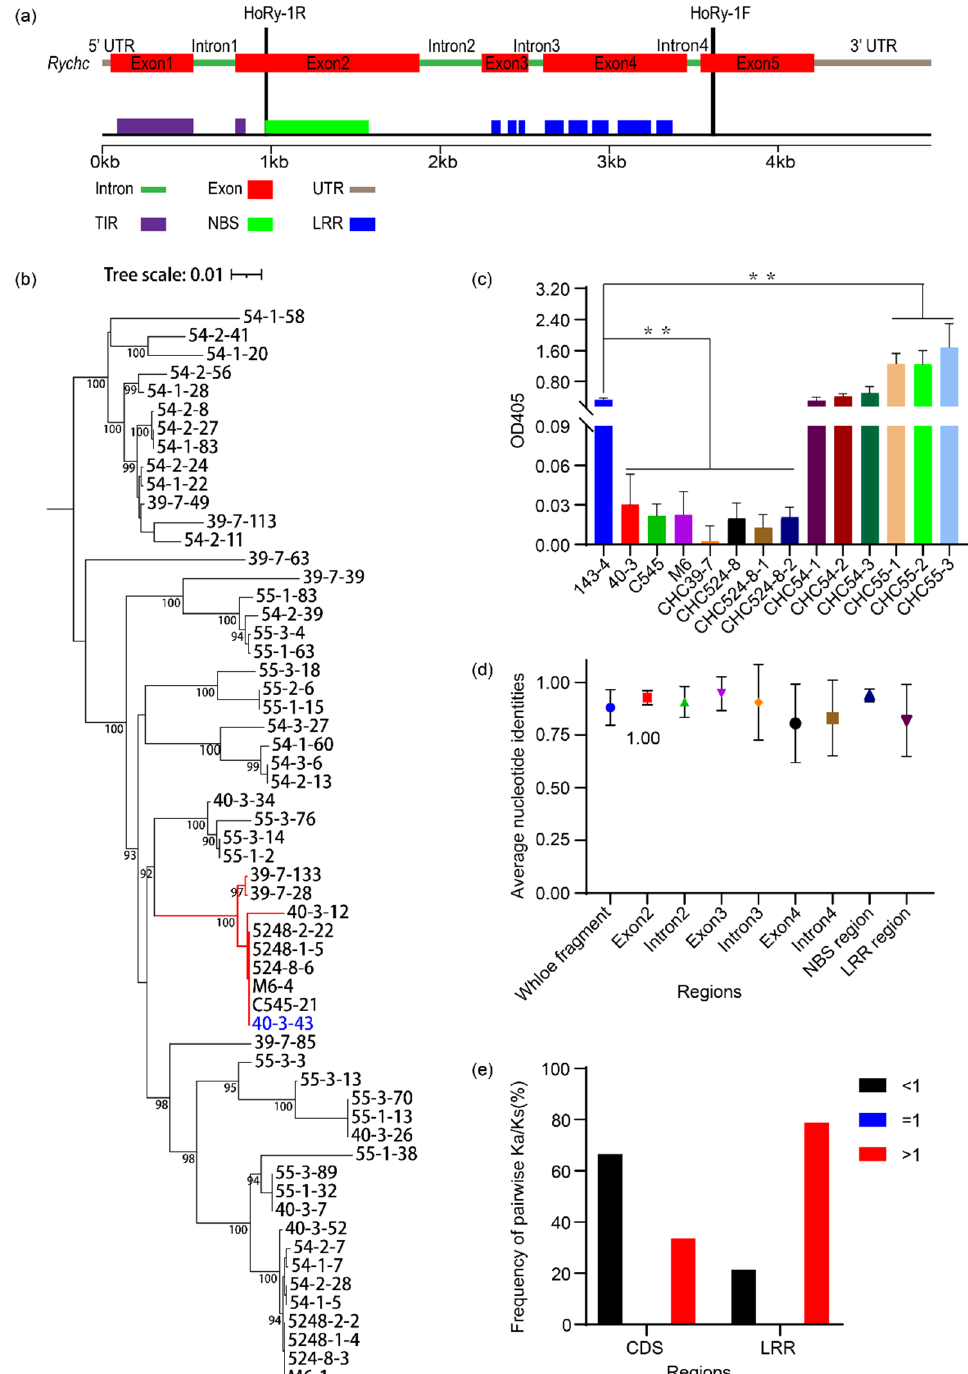
Figure 6. Evolution of Ry chc homologs in diverse wild accessions of S. chacoense . ( a ) Genomic structure and conserved domains of Ry chc ; ( b ) Maximum Likelihood (ML) phylogenetic tree of the Ry chc homologs from Family 11. 40-3-43 in blue is the fragment of Ry chc ; ( c ) Phenotyping of PVY resistance in 12 accessions of S. chacoense . Data in ( c ) are presented as mean values ± SE. ** indicates a statistically significant difference ( p < 0.01) relative to 143-6, as determined using a Student’s t -test. The 40-3 indicates S. chacoense accession 40-3, the resistant parent. The 143-6 indicates S. berthaultii accession 143-6, the susceptible parent; ( d ) Average nucleotide identities of different parts of all Ry chc genes fragments; ( e ) Distribution of Ka/Ks values in the CDS and LRR regions of Ry chc genes from Family 11.